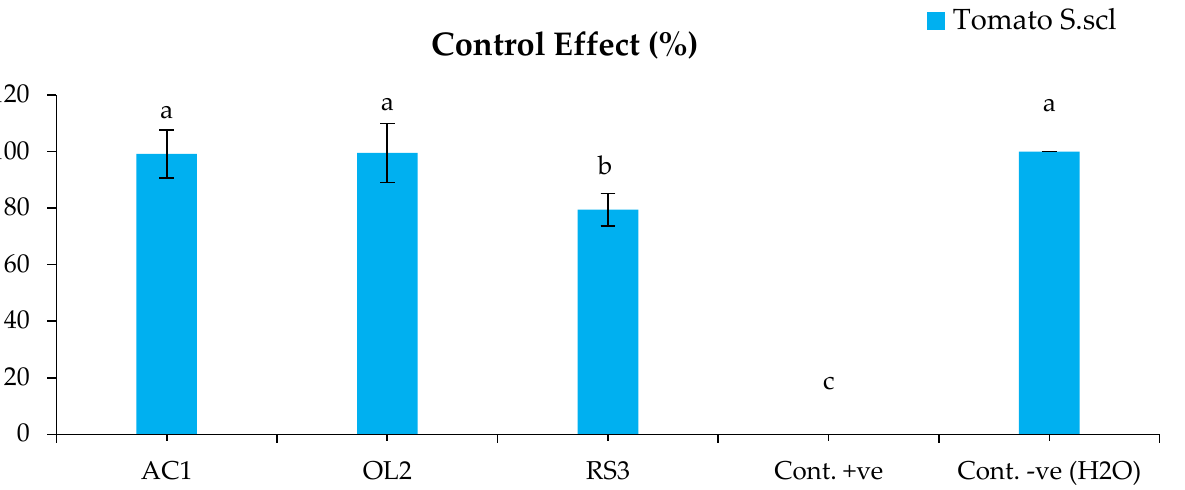
Figure 1. Disease index of tomato inoculated with S. sclerotiorum . Bars with different letters indicate mean values significantly different at p < 0.05 according to Tukey ’s B test. Data are expressed as mean of 3 replicates ± SDs. DI (%) = [Σ (Scale × No. of SL)/(HS × TL)] × 100 (Equation (1)). AC1, OL2, and RS3 are Streptomyces sp., Arthrobacter humicola, and Streptomyces atratus , respectively.